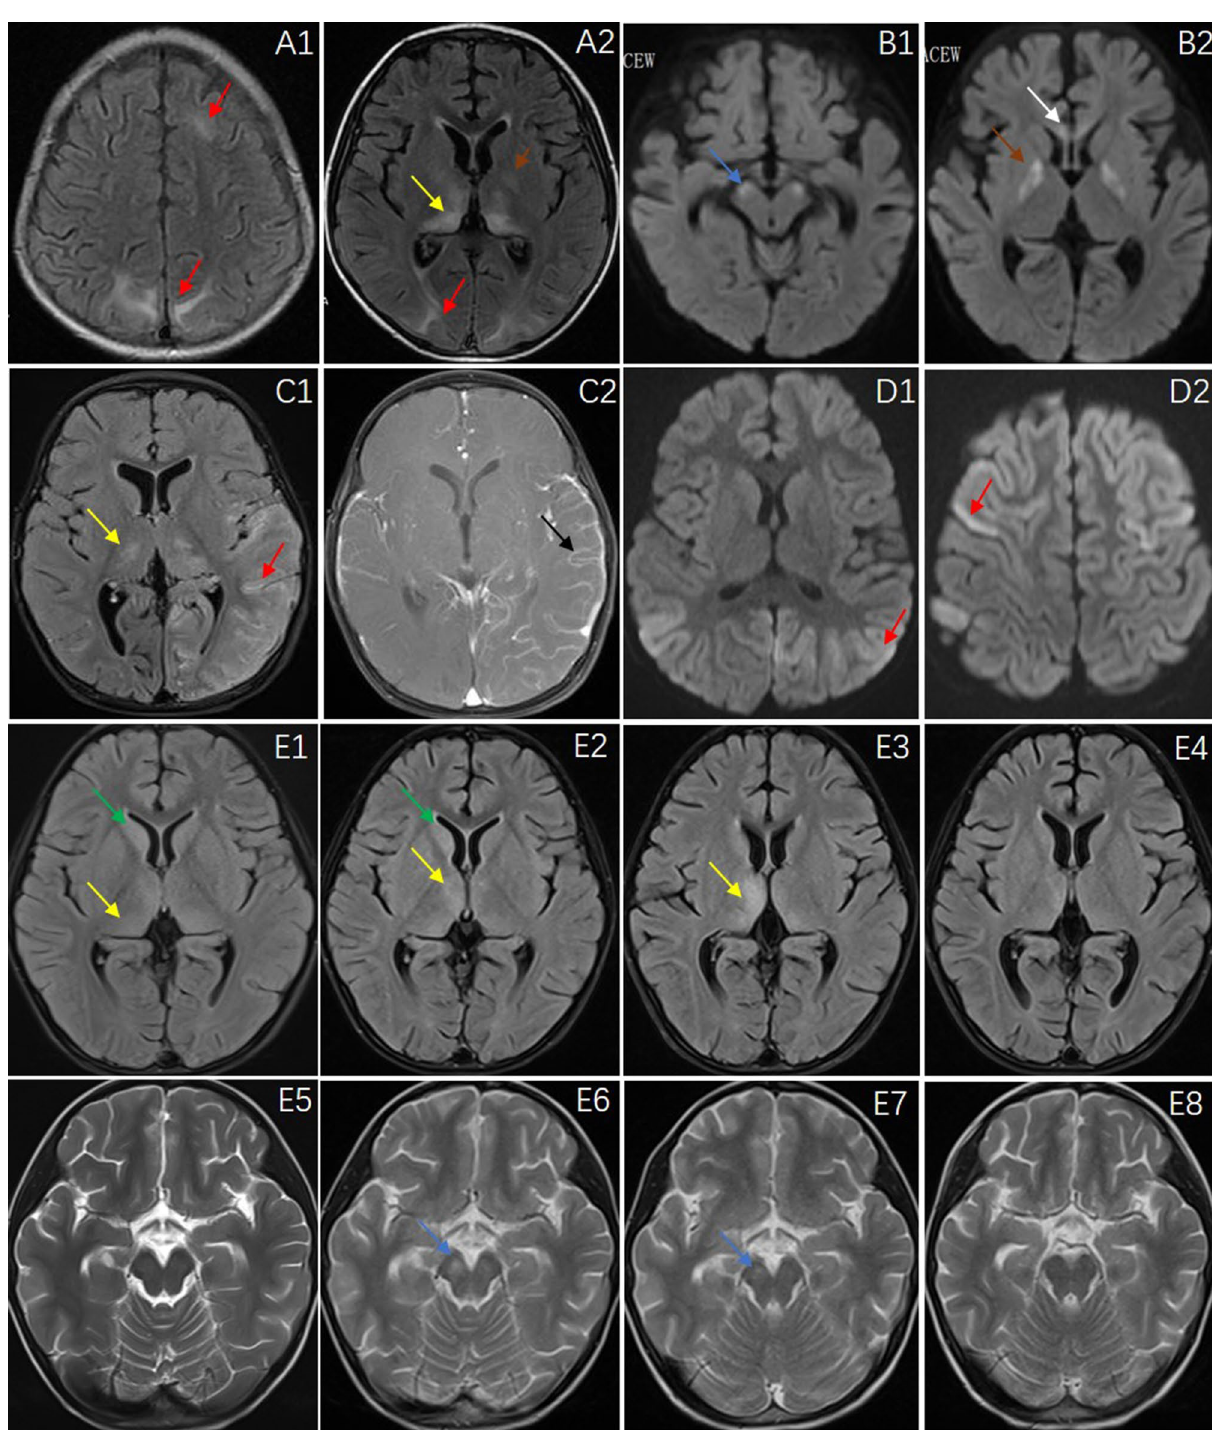
Figure 2. Brain MRI features of patients N.3, N.5, N.6, N.8 and N.10. Patient N.3, a 6-year-old boy, had a clinical-radiological presentation of Morvan syndrome including multifocal lesions in the occipital and parietal cortex and thalamus ( A1 , A2 ). Patient N.5, a 5-month-old boy, presented with encephalopathy and bilateral MRI abnormalities in the globus pallidus, corpus callosum and cerebral peduncle ( B1 , B2 ). Patient N.6, a 2-year-old girl, had a clinical-radiological presentation of autoimmune encephalitis, including cortical lesions in the frontal, parietal, occipital and temporal lobes and thalamus and cortical lesions showing enhancement with gadolinium administration ( C1 , C2 ). Patient N.8, a 5-year-old girl, presented with two episodes of fever and seizures within a week. Brain MRI showed extensive cortical lesions in the frontal, parietal, occipital and temporal lobes ( D1 , D2 ). Patient N.10, a 6-year-old boy, presented with fever, ataxia, slow responses. Brain MRI ( E1 – E8 ) showed a series of changes including lesions in the thalamus, caudate nucleus and cerebral peduncle (E1/E5, E2/E6, E3/E7, E4/E8, representing D4, D16, D30, and D50 after onset, respectively). Fluid-attenuated inversion recovery sequences were used in ( A1 , A2 , C1 , E1 – E4 , and C2 , which show enhancement with gadolinium administration. T2 sequences were used in ( E5 – E8 ). Diffusion weighted imaging was used in ( B1 , B2 , D1 and D2 ). Red arrows represent multiple cortical lesions, yellow arrows: thalamus, blue arrows: cerebral peduncle, green arrows: caudate nucleus, brown arrows: globus pallidus, white arrow: corpus callosum, black arrow: meningeal